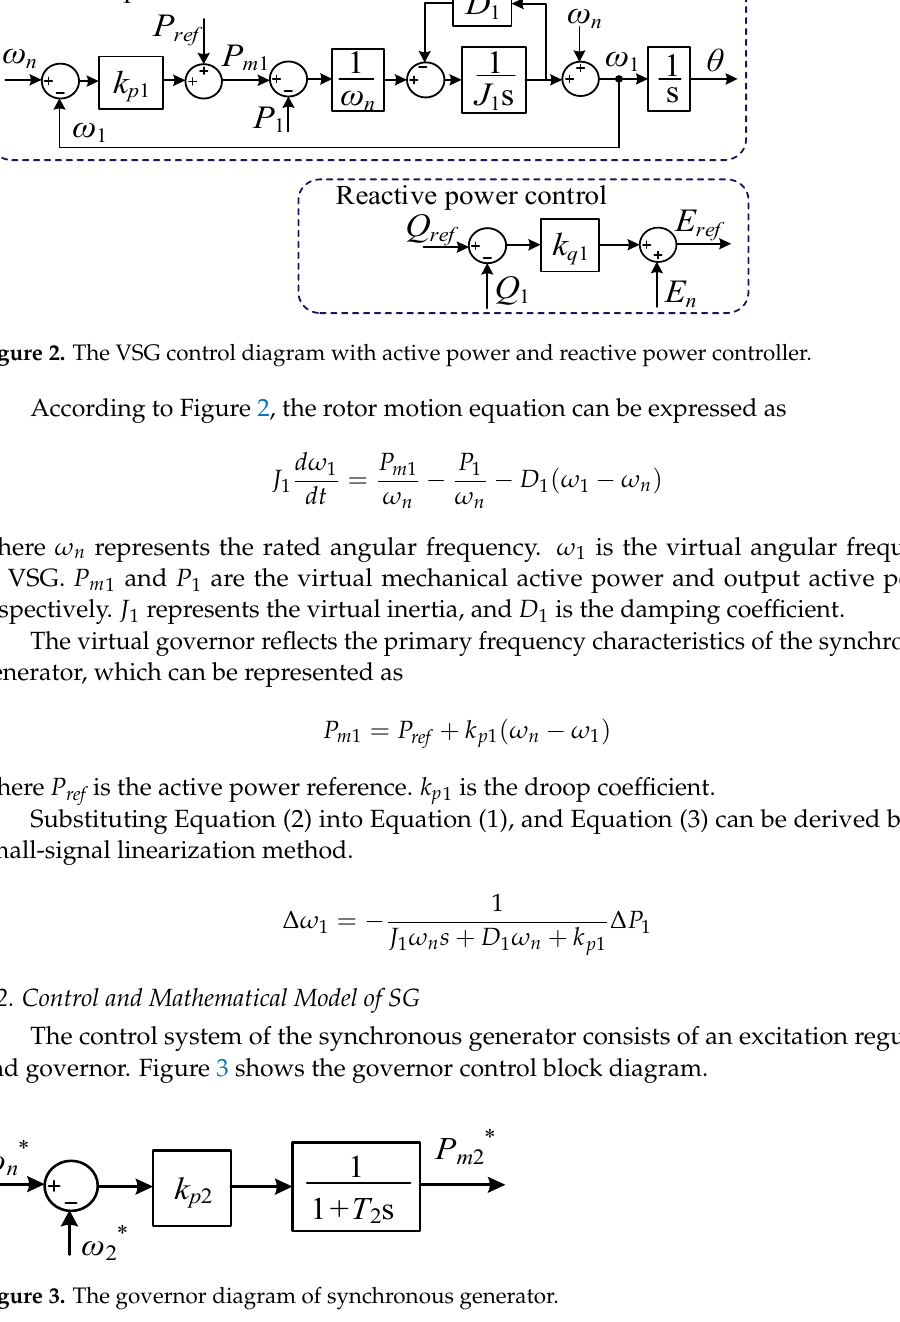
Figure 2. The VSG control diagram with active power and reactive power controller.